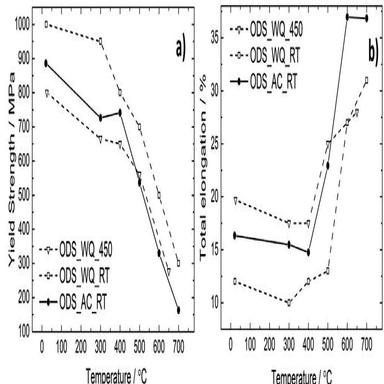
a) Yield strength (σy) and b) total elongation (εt) as a function of temperature for ODS_AC_RT in the longitudinal direction. For ODS_WQ_RT, the tensile test data has been obtained from McClintock et al & Byun et al. and for ODS_WQ_450, it has been obtained from Chaouadi et al.